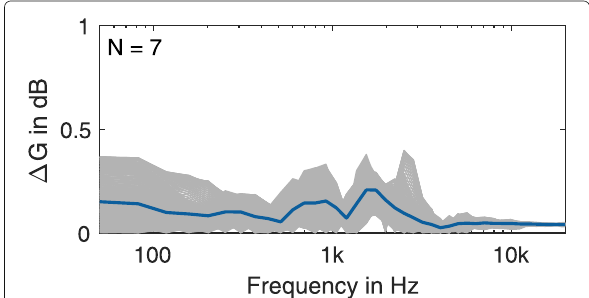
Fig. 5 Working Example 2: Left-ear absolute energetic difference (cid:4) G in auditory gammatone filter bands between BRTFs resulting from the SOFiA (reference) and the SMATBIN filter processing ( K = 2048 taps) for 360 head orientations in the horizontal plane (1° steps from 0° to 360°) and impulse responses of a classroom for a rigid sphere array with a Lebedev sampling scheme of order N = 7. The gray lines show the difference for each individual head orientation, the blue line shows the difference averaged across all head